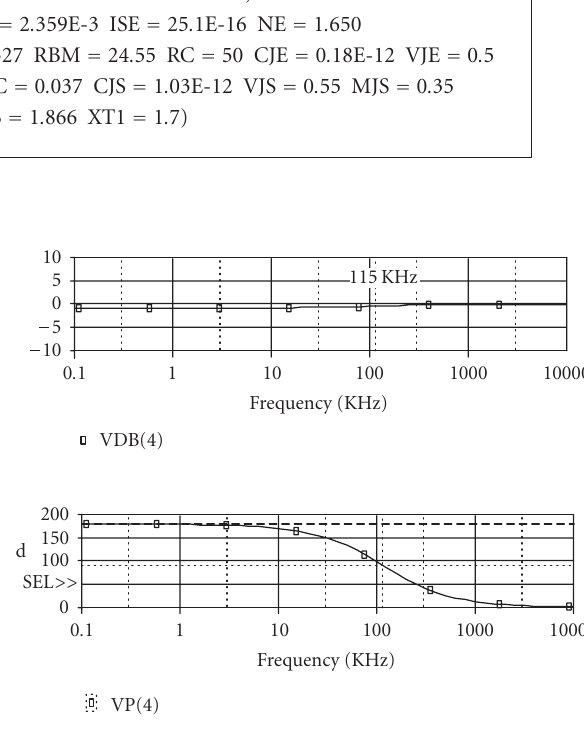
Figure 6: Frequency response of Circuit-2 using